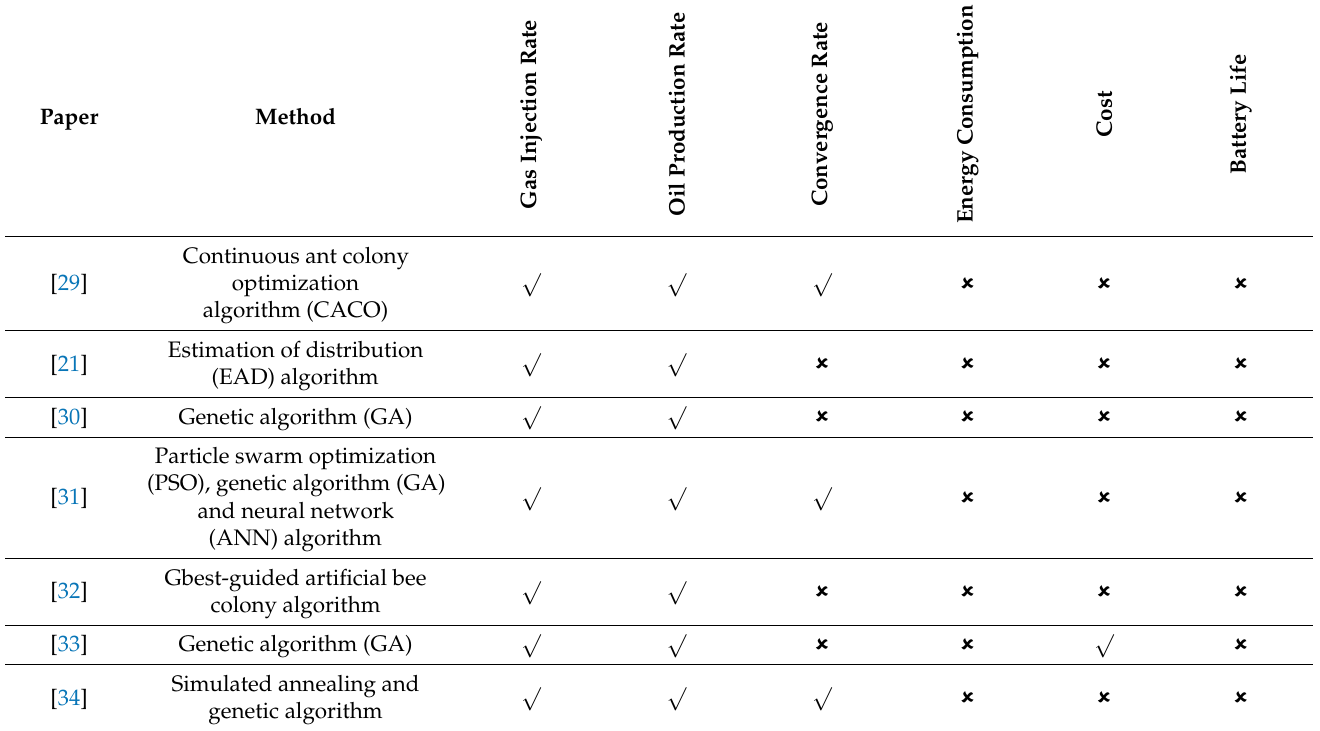
Table 1. Comparative studies of existing systems considering the identified challenges.